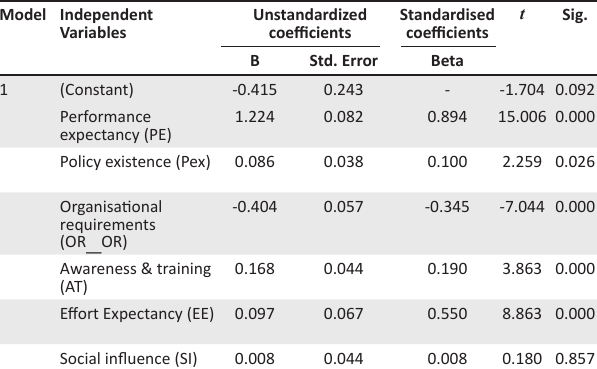
TABLE 4: Summary of results.